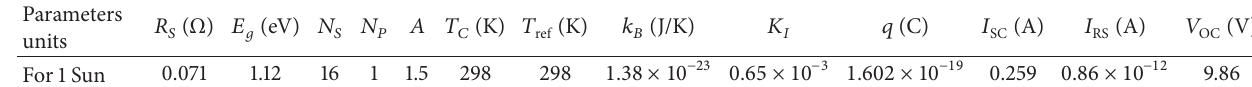
Table 2: The parameters used for simulation under 1 Sun.